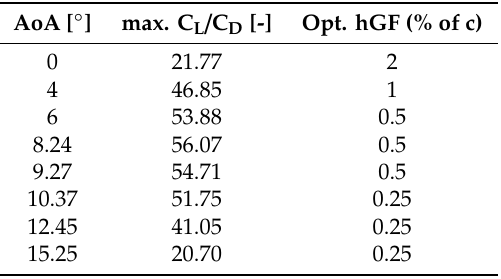
Table 3. Optimum GF lengths for each angle of attack.